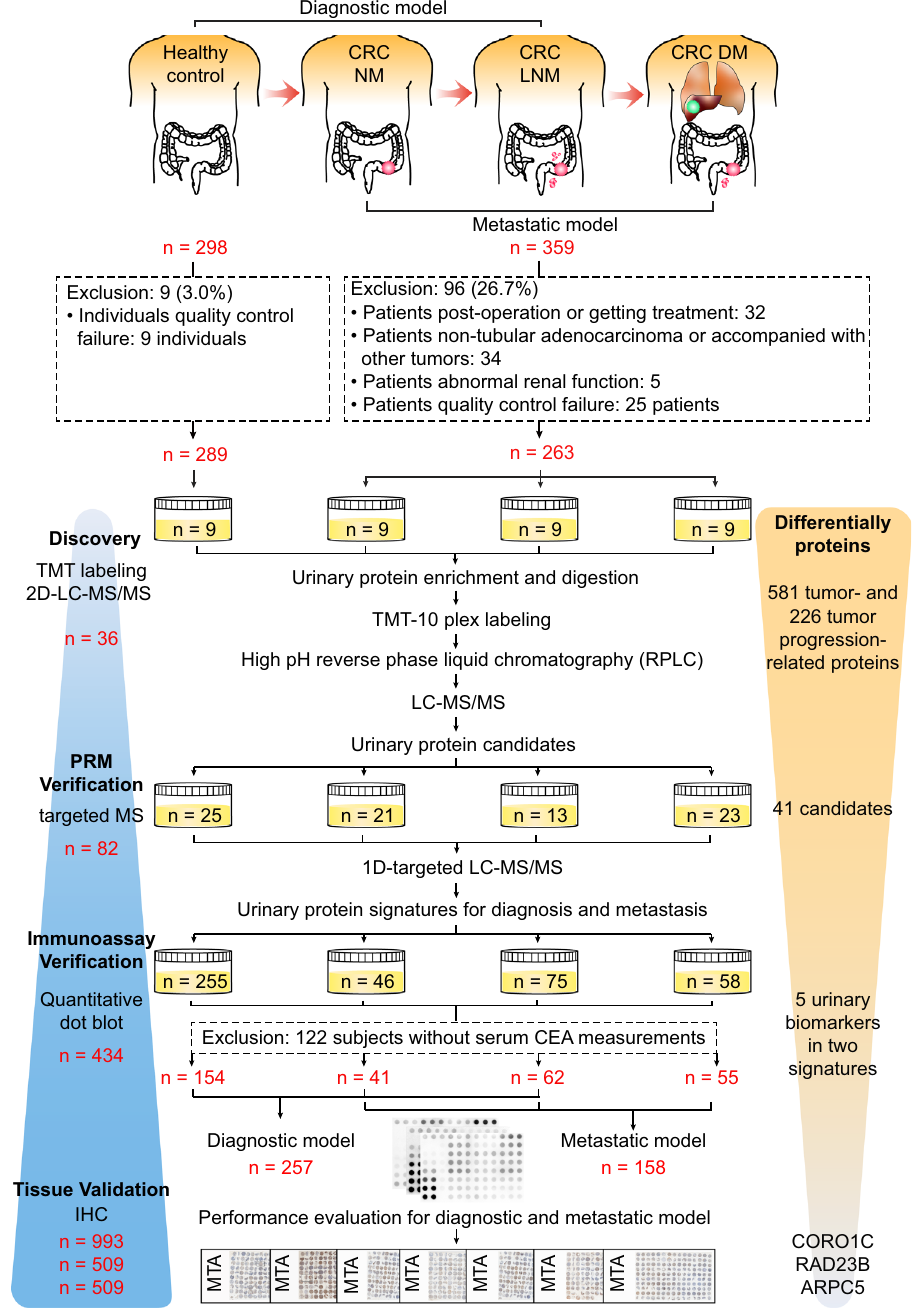
Fig. 1 The overall work fl ow of study sample inclusion and exclusion criteria as well as the discovery, PRM veri fi cation, immunoassay veri fi cation, and tissue validation for CRC urine biomarkers. The detailed inclusion and exclusion criteria of the samples are shown. CRC patients were divided into three groups by metastatic status: patients without metastases (NM), patients with lymph node metastasis (LNM), and patients with distant metastasis (DM). The four-stage work fl ow consisted of a series of mass spectrometry (MS) and immunoassay-based approaches, including the tandem mass tag (TMT) labeling-2D-LC-MS/MS quantitative proteomic strategy, parallel reaction monitoring (PRM)-based targeted proteomic method, quantitative dot blot analysis and tissue immunohistochemistry (IHC), to construct a coherent and high-throughput cancer biomarker method in urine. CRC colorectal cancer, MTA multi-tissue